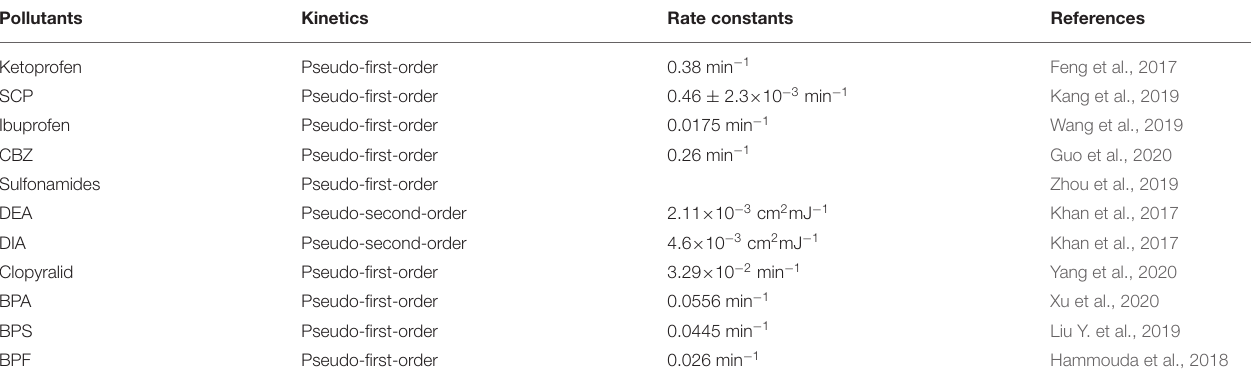
TABLE 4 | Kinetics model and rate constants of organic pollutants via